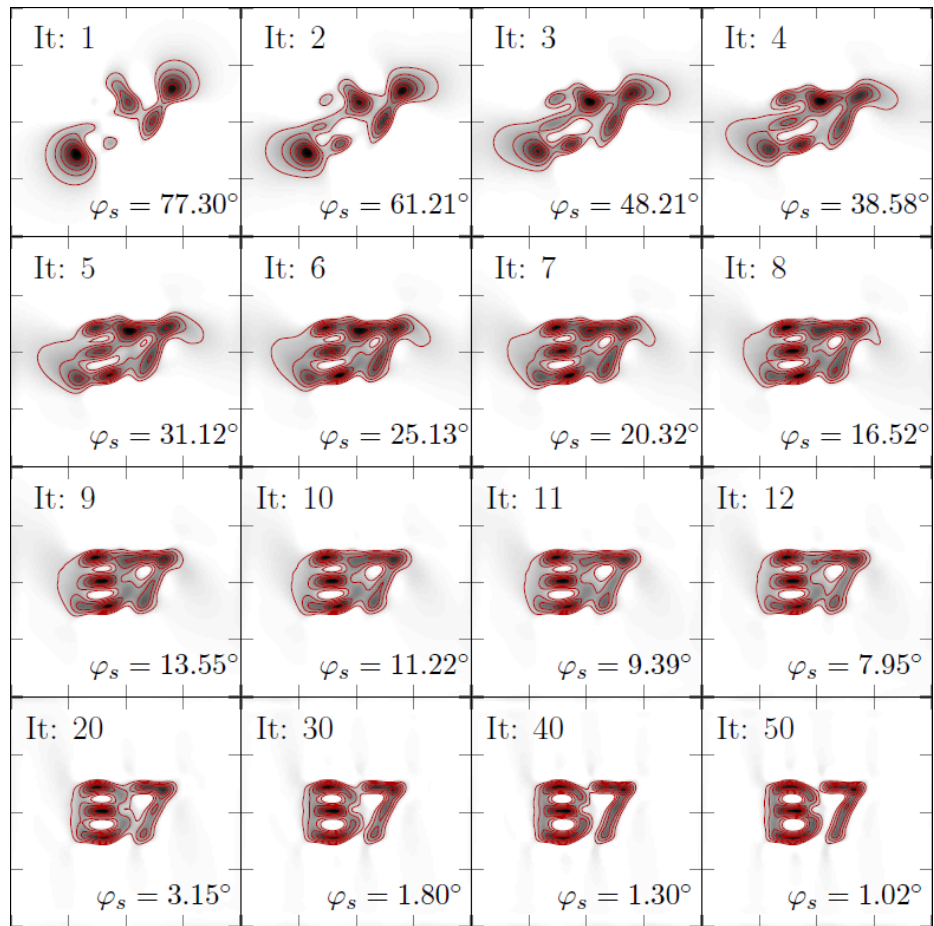
Figure 7. Adaptive reconstruction to iterate the MNP distribution x and the sensitive axis s simul- taneously. Shown are individual iterations as denoted in the upper left corner of each subplot. In the lower right corner of each subplot, the estimated sensitive axis direction (polar) is shown. The ground truth for this axis has an angle of ϕ m = 0 ◦ . The black color indicates MNPs, and the red lines are level sets to guide the eye. Dimensions of each square correspond to an area of 20 × 20 mm 2